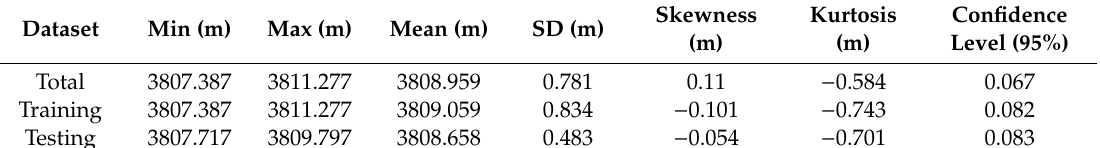
Table 1. Water level data used for the duration of the study period (1973–2017).